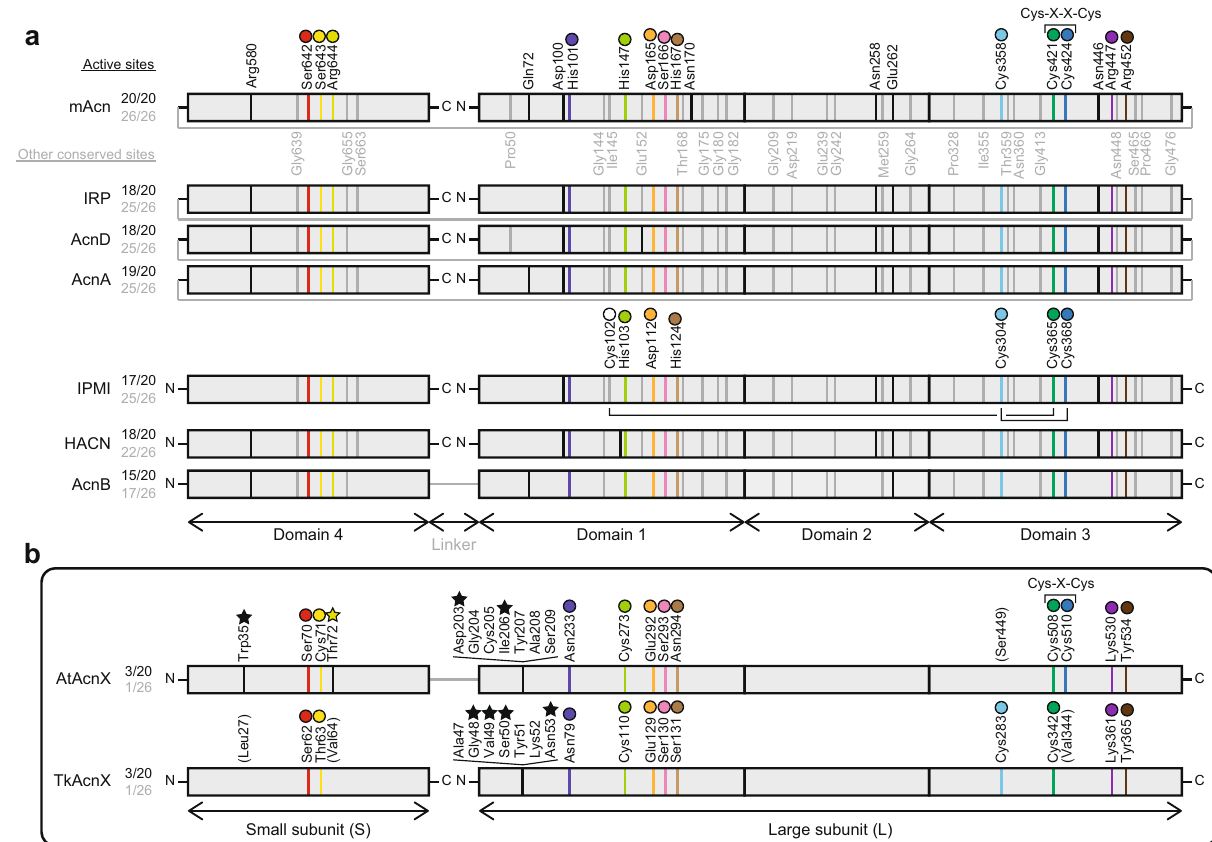
Fig. 2 Comparative sequence analysis of aconitase superfamily enzymes. a Other aconitase enzymes. Black and gray letters indicate 20 of the active site residues that are completely conserved in all aconitase enzymes, except for AcnX, and 26 of the fully conserved residues that have not been identi fi ed as part of the active site, respectively 13 . Active sites with the same colored circles are located at equivalent (or close) positions between other aconitase enzymes and AcnX. The open circle in IPMI is the fourth cysteine residue near the [4Fe-4S] cluster (see Fig. 4i). b AcnX. The amino-acid residues with black stars indicate speci fi c active sites for C3LHyp dehydratase and MVA5P dehydratase. A more-detailed structural-based alignment is shown in Supplementary Fig.